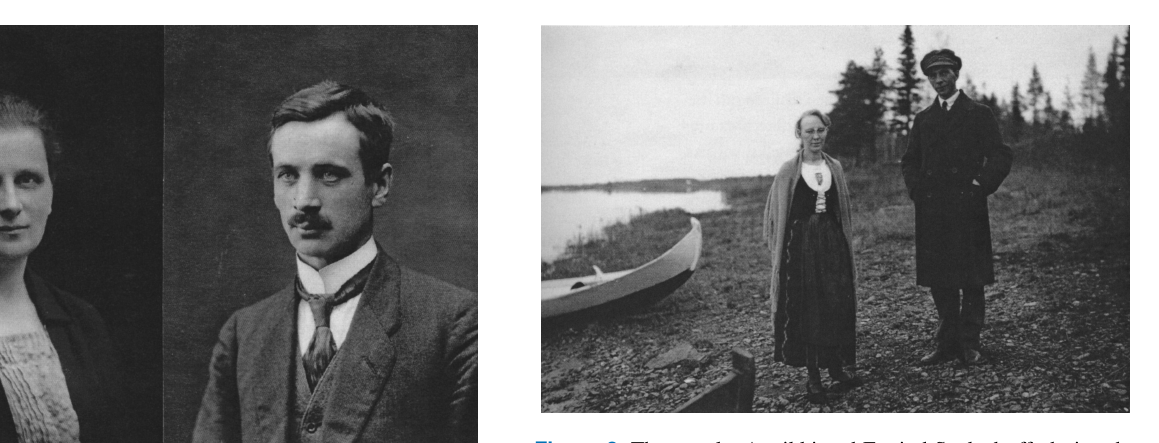
Figure 2. The couple, Annikki and Eyvind Sucksdorff, during the Second International Polar Year in 1932. The photo is taken at the site of the observatory on the shore of the river Kitinen. Annikki is wearing a traditional dress, and Eyvind is dressed in a local au- tomobile club uniform. Sucksdorff headed the SGO between 1927 and 1945, and Annikki was his assistant. They had three children, all born in SOD (photo taken by Lyyli Takki and supplied by the Työväen